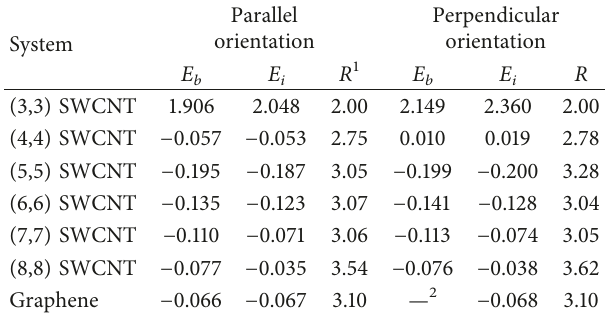
1 The equilibrium distances ( R ) are measured between an H the closest wall of a SWCNT; 2 for graphene, there is only one value of E b as the initial parallel and perpendicular orientations converge to one equi- librium